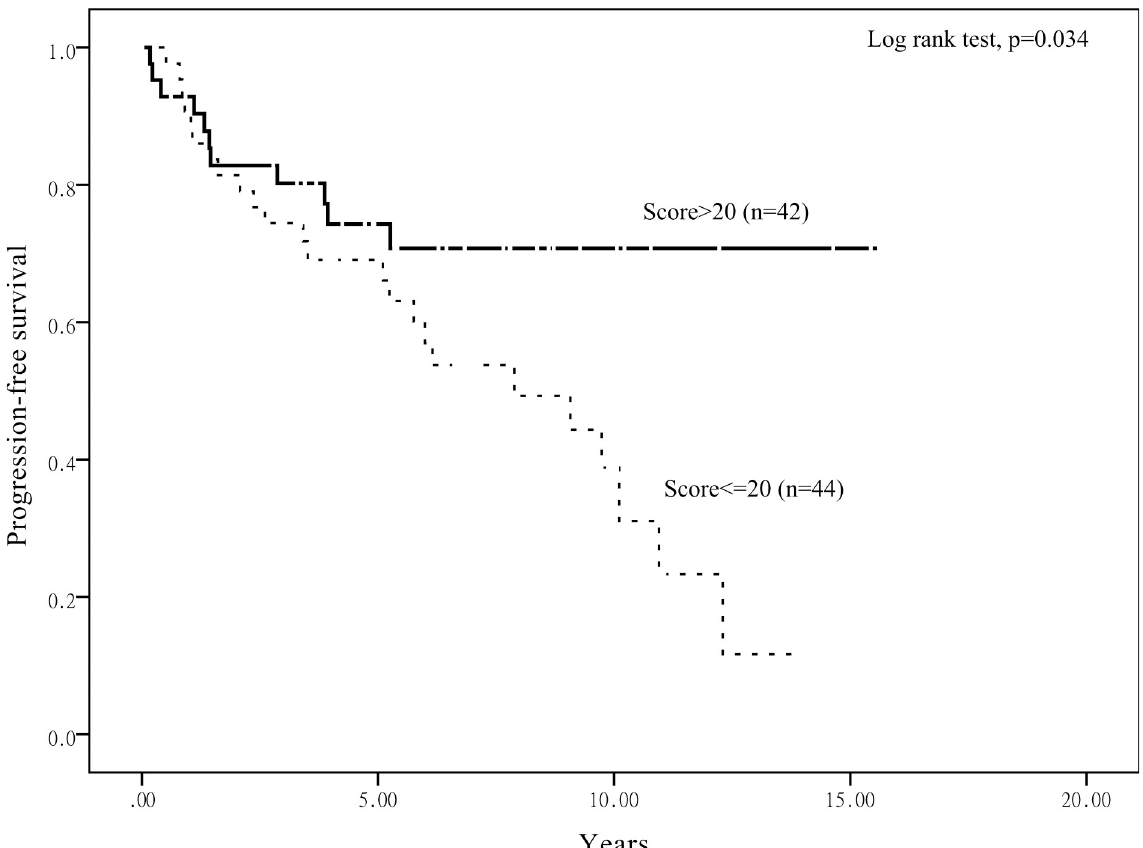
Fig 5. Kaplan–Meier analysis stratified according to TET1 expression score. Analysis to assess the prognostic value of the TET1 immunoreactivity in relation to PFS.